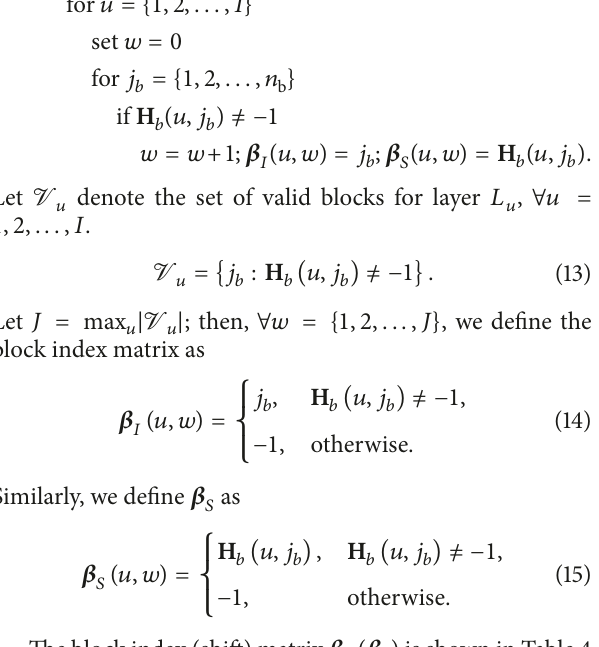
(Table 5) for the case of the IEEE 802.11n rate- 1/2 LDPC